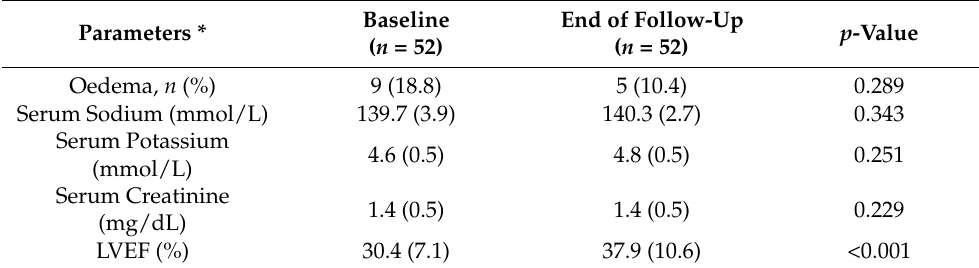
Table 2. Evolution of renal and cardiac parameters, from baseline to last follow-up. Parameters *